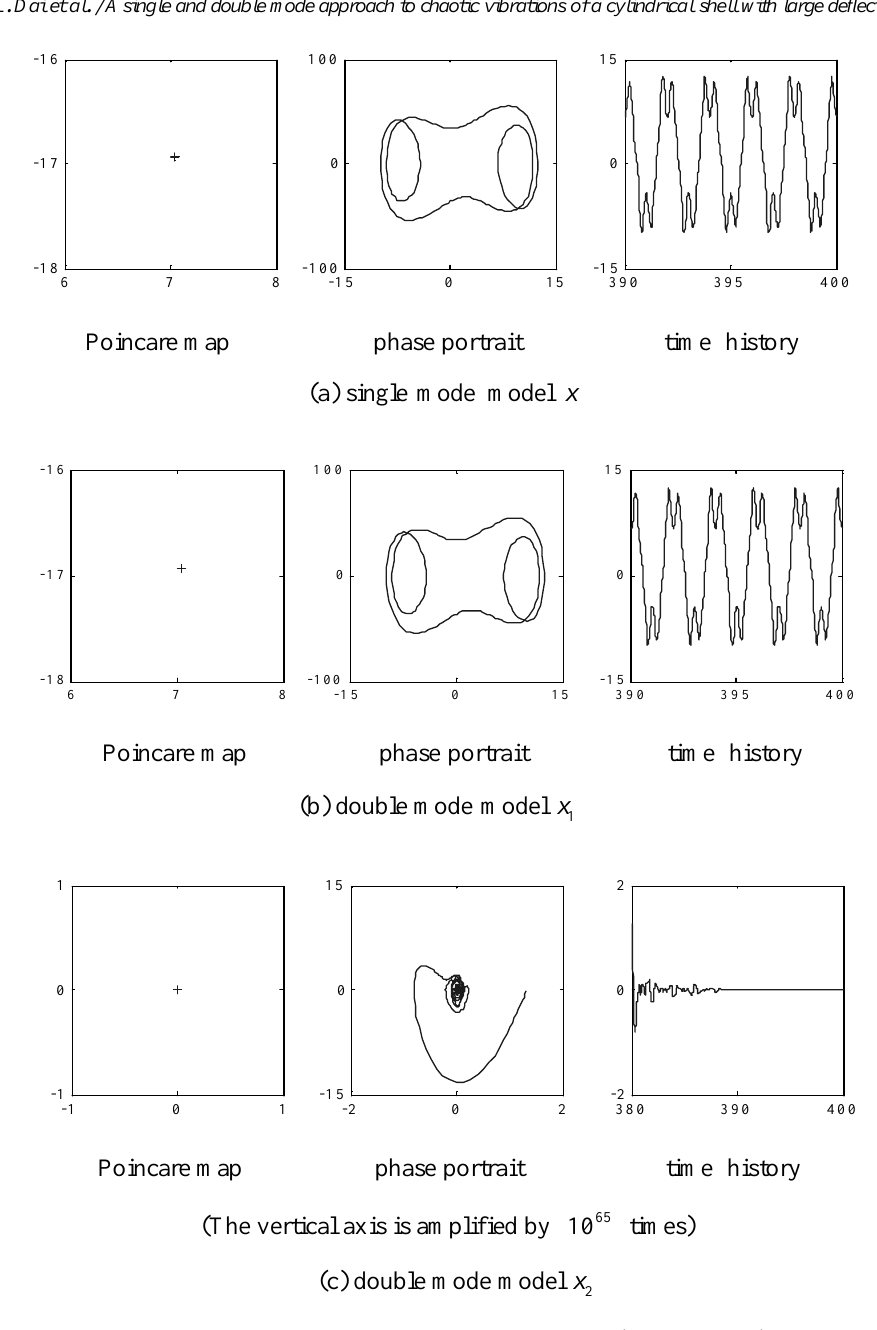
Fig. 3. Comparison between single and double mode models ( ω = π,g = 610